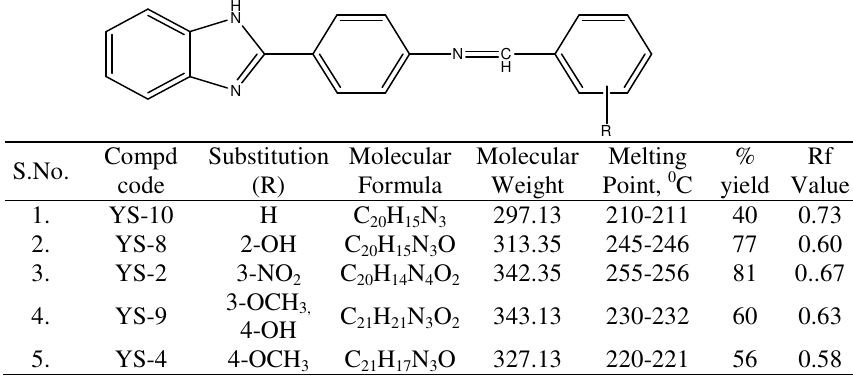
Table 2. Schiff bases derived from 2-(4- aminophenyl) benzimidazole (YS-B).